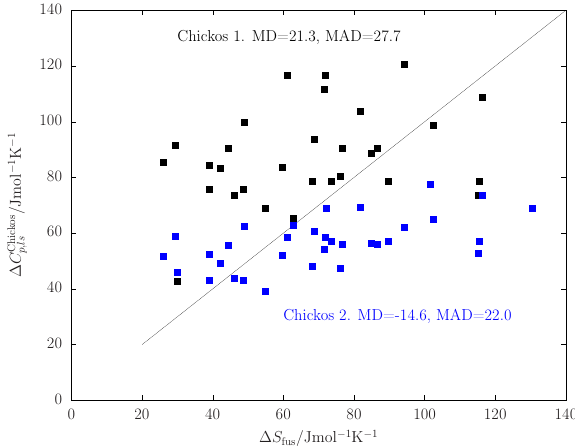
Fig. 1 the sensitivity of ω ls (T ) on the two extreme approx-